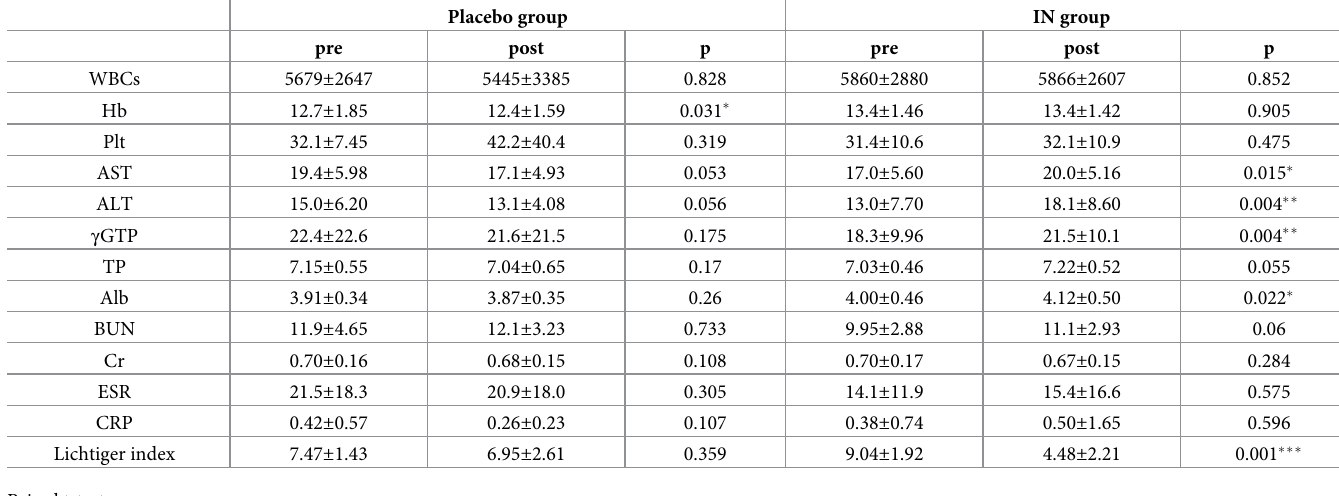
Table 2. Data comparison before and after the intervention in each